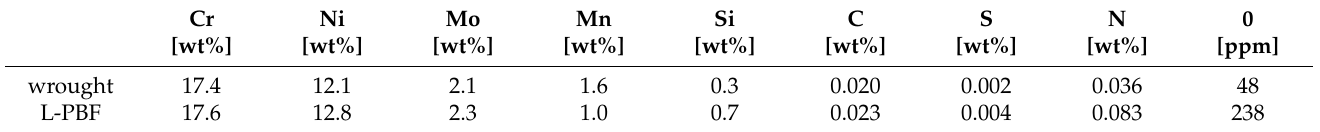
Table 1. Chemical composition of L-PBF and wrought AISI 316L stainless